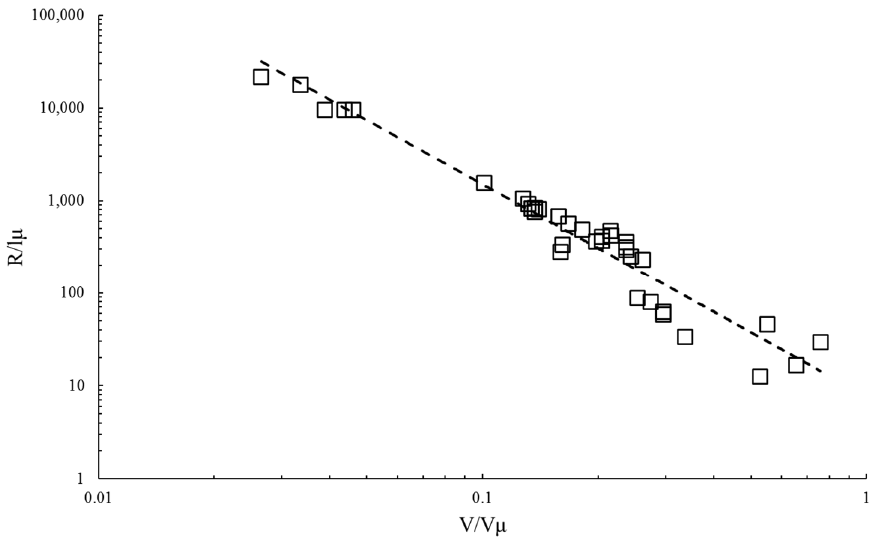
Figure 10. Dimensionless satellite droplet radius R / l μ as a function of the dimensionless axial jet velocity V / V μ for more viscous solutions with >40% G with the power law fit R / l μ ~( V / V μ ) − 1.69 .